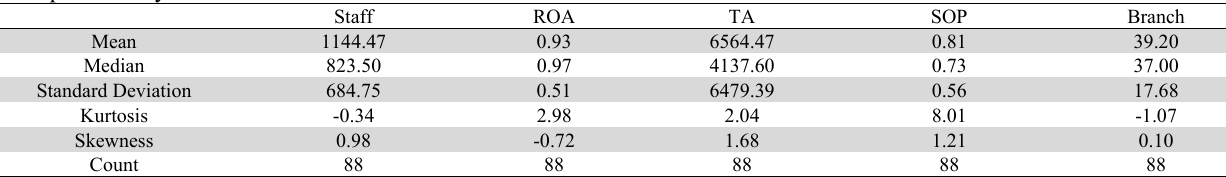
Descriptive Analysis